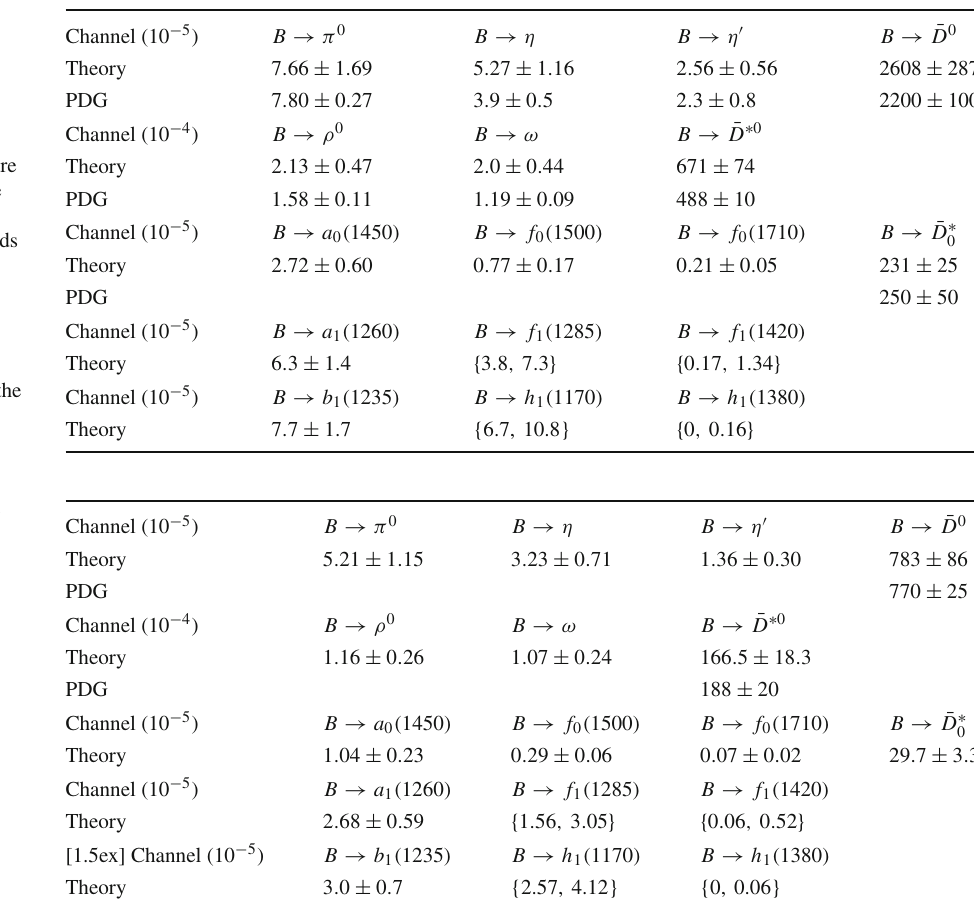
Table 6 Same as Table 5, but for the tau lepton